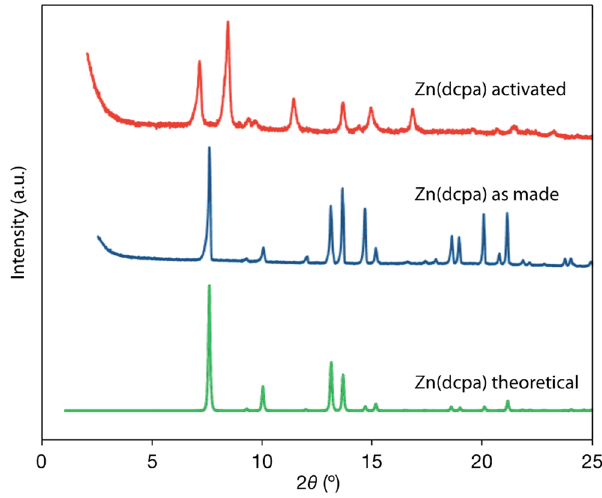
Figure 2. PXRD diffraction pattern for activated, as made, and theoretical Zn(dcpa) samples. The thermal stability of the sample was also characterized by TGA; the recorded sample mass as a function of the heating temperature is shown in Figure 3. The results show an initial mass decrease (~10%) from room temperature up to around 400 K, due to the removal of pre-adsorbed impurities and humidity, due to MOF exposure to the indoor atmosphere just prior to the analysis. MOF was stable up to 650 K, after which a steep decrease in the mass was observed, reaching a mass decrease of 50%, similar to the behavior observed by Liu et al. [34]. Above 750 K, the Zn(dcpa) mass decreased more smoothly until reaching the remaining experimental amount of ca. 25% at 1130 K.